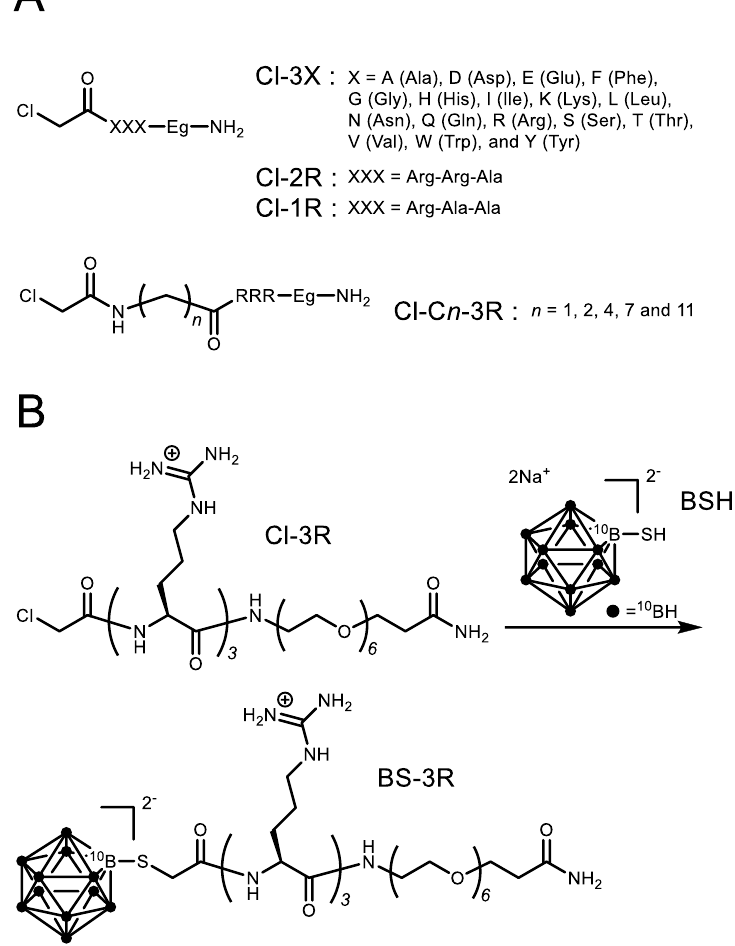
Figure 1. ( A ) Chemical structures of chloroacetyl-modified tripeptides (Cl-3X, Cl-2R and Cl-1R) and chloroacetyl-modified tripeptides into which an alkyl linker (Cl-Cn-3R) was introduced. Eg indicates a water-soluble linker consisting of six ethylene glycol residues. ( B ) Representative route of synthesis of BSH-modified tripeptides (BS-3R) from Cl-3R.